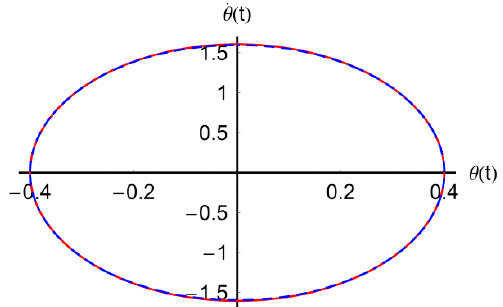
approximate solution (50).